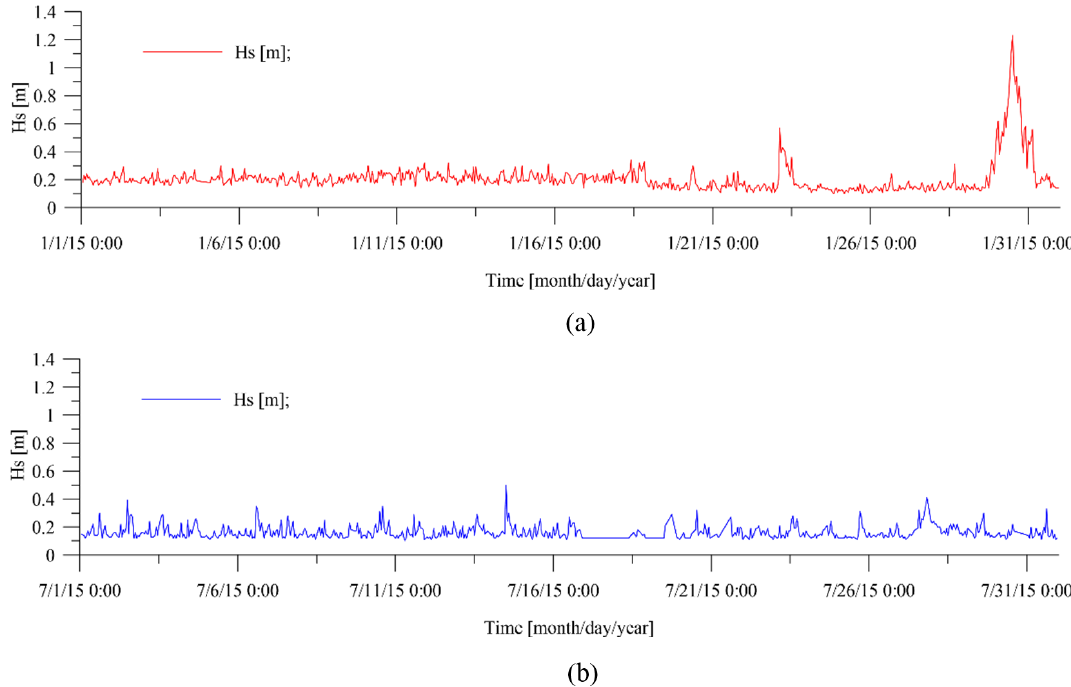
Figure 7. Time series of measured significant wave heights H s recorded in (a) January 2015 and (b) July 2015. Time is local time.